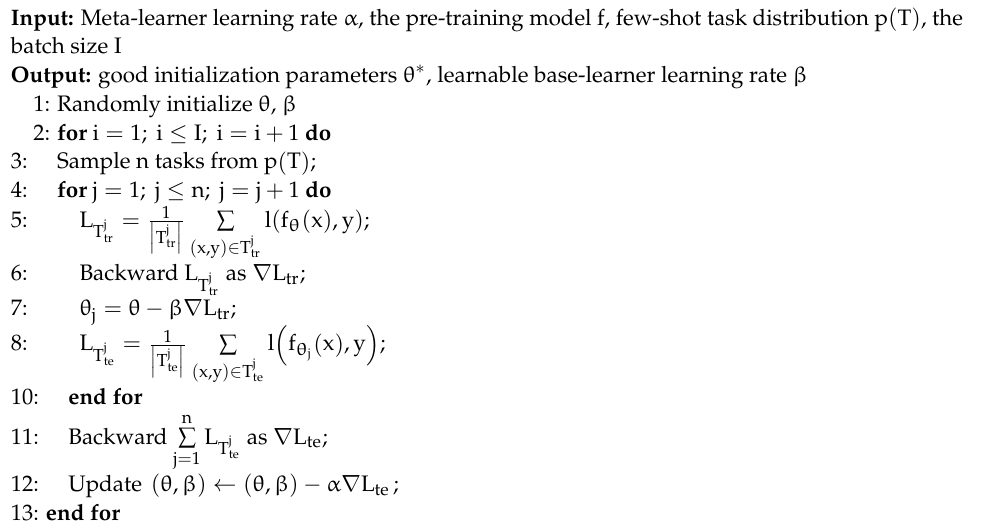
Algorithm 1. Pre-training feature